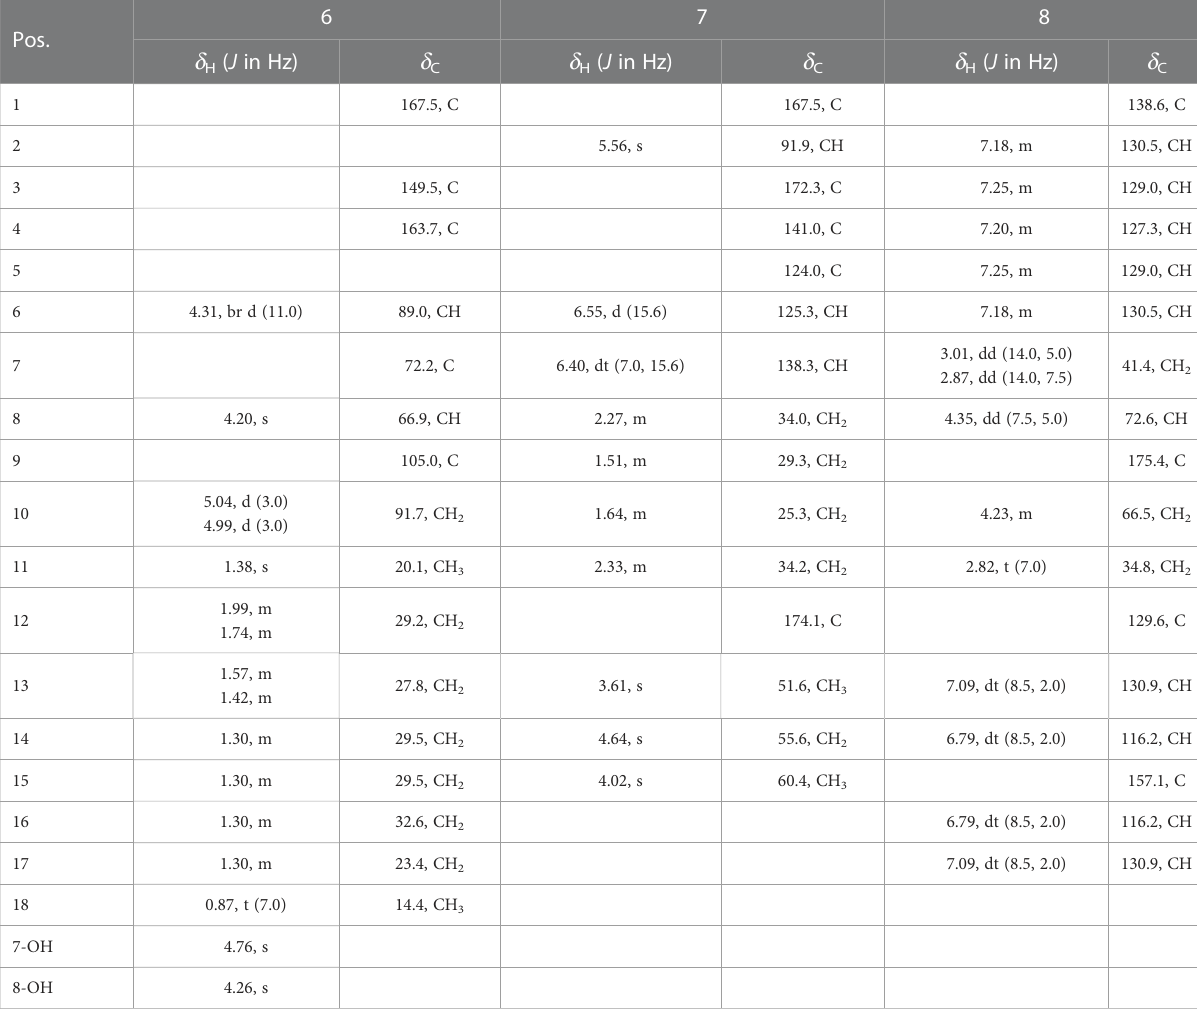
TABLE 2 ｜ 1 H NMR (500 MHz) and 13 C NMR (125 MHz) data for 6 − 8 in acetone- d 6.